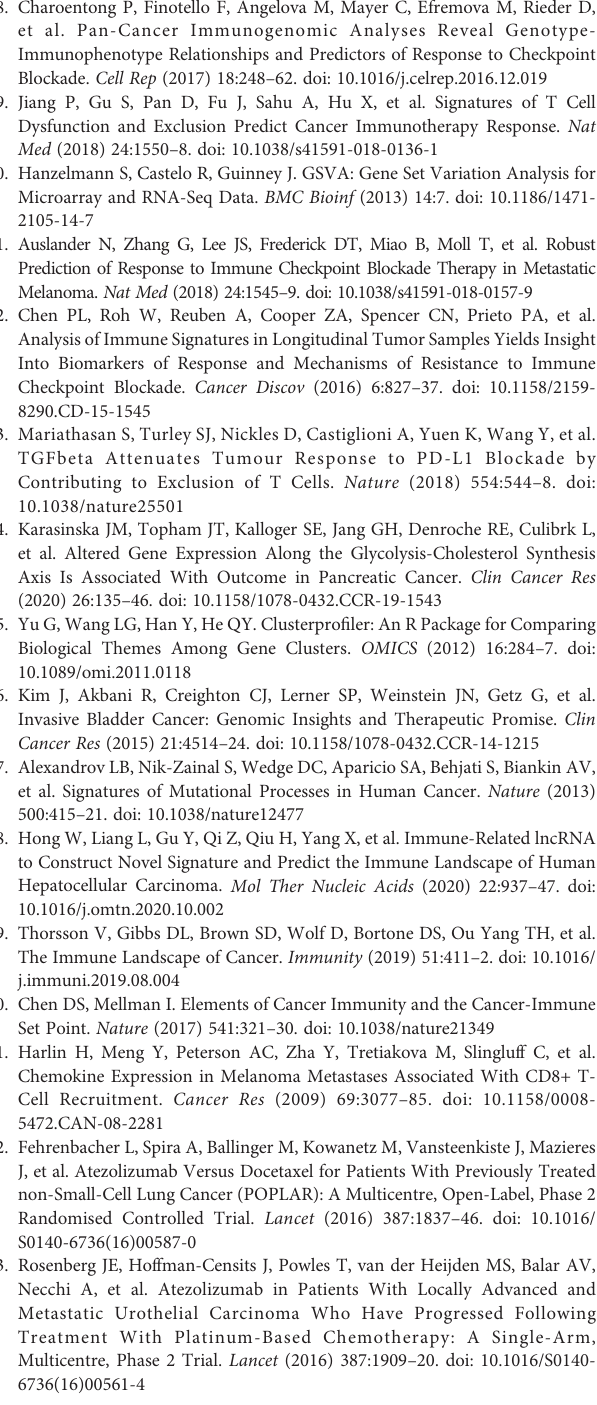
Supplementary Figure 11 | Survival analysis using the TCscore combined with other factors. (A – J) . Kaplan – Meier survival analyses were performed based on the TCscore plus the following factors: mutation statuses of (A) TP53 , (B) ARID1A , (C) AXIN1 , (D) CTNNB1 ,and (E) TTN , (F) historyofalcoholism, (G) hepatitisBvirusinfection, (H) hepatitis C virus infection, (I) PDCD1 expression, and (J) tumor mutation burden.